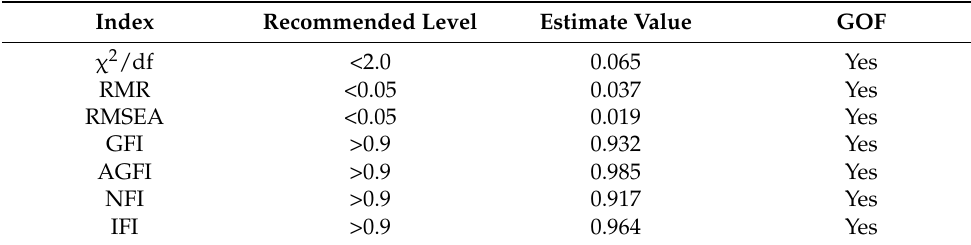
Table 5. Goodness of fit.